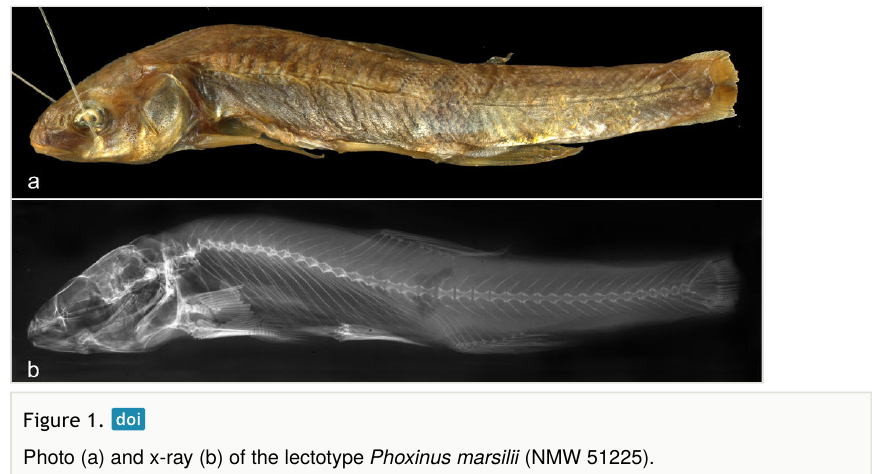
Figure 1. Photo (a) and x-ray (b) of the lectotype Phoxinus marsilii (NMW